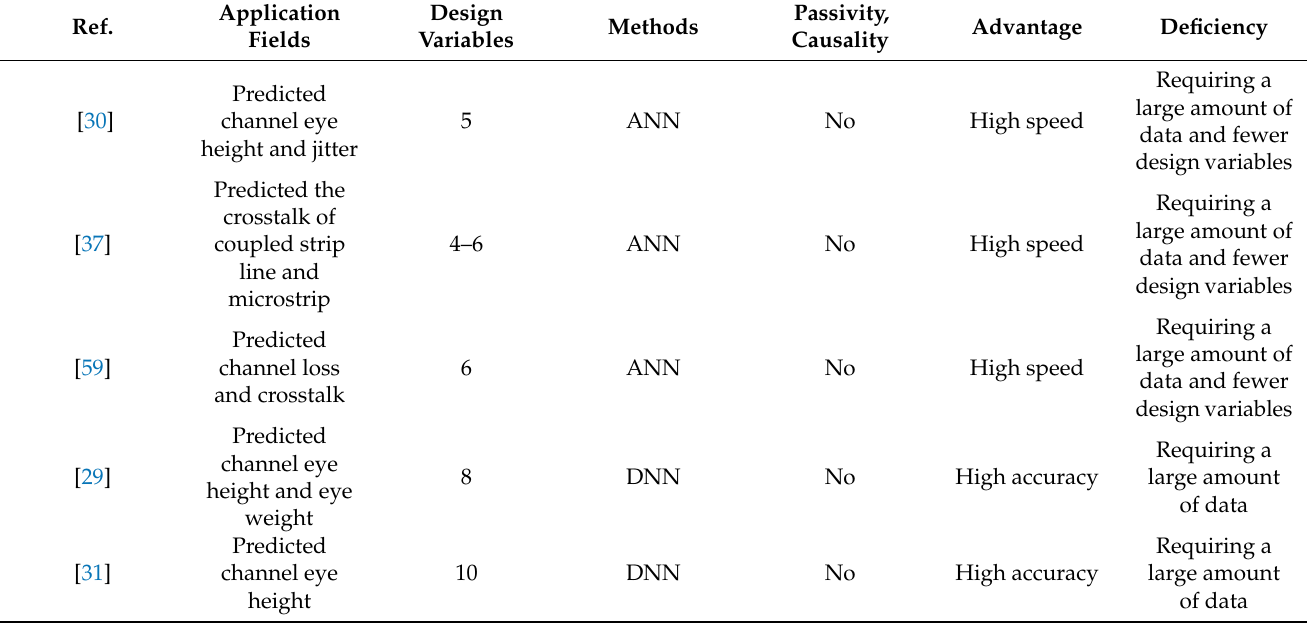
Table 1. Comparison of SI prediction